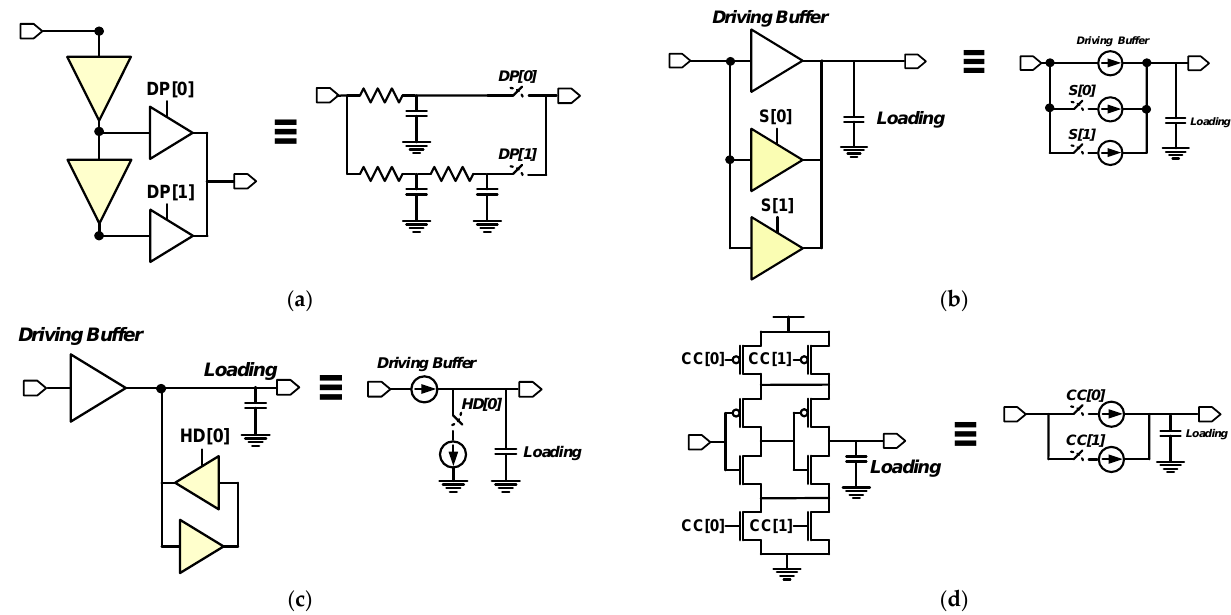
Figure 2. The circuit structure of ( a ) delay-path-type-digitally controlled delay element (DP-DCDE); ( b ) shunt-type (S)- DCDE; ( c ) hysteresis-delay (HD)-DCDE; ( d ) current-controlled (CC)-DCDE.